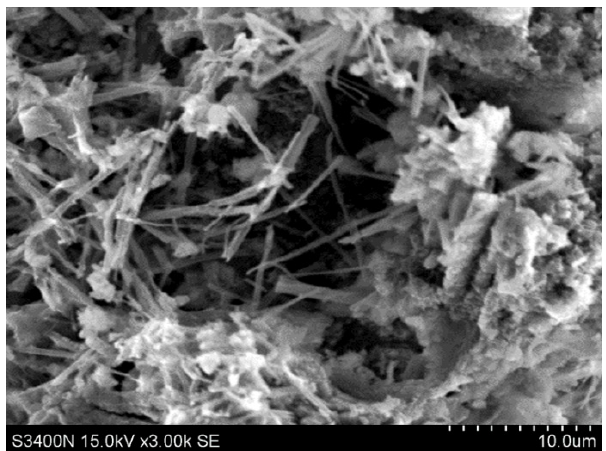
Figure 17. SEM image of the microstructures 5 mm below the inner coating of the substrate when W/C = 0.6 (3000×; 4C2, 56 days).